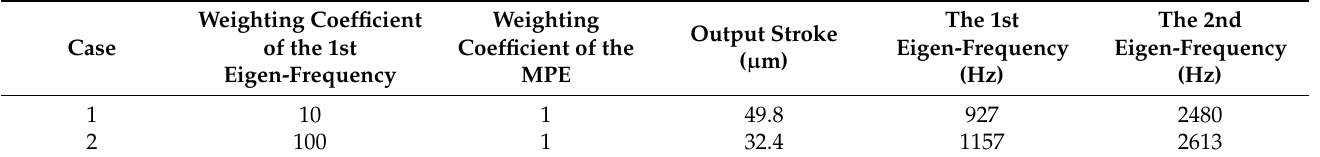
Table 2. Two types of optimized result with different weighting coefficient of the 1st eigen-frequency.